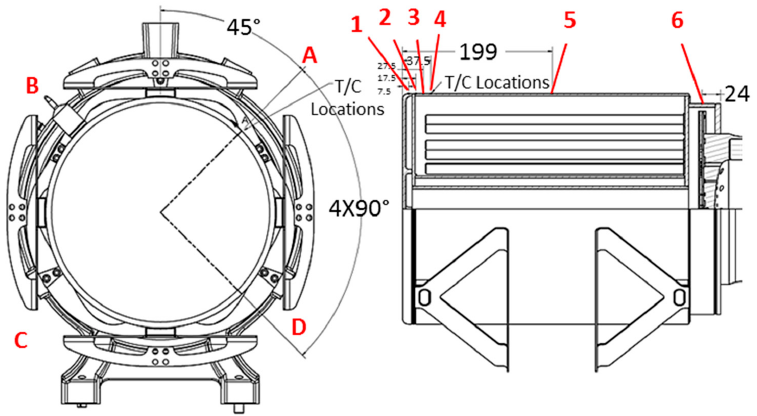
Figure 8. Radial and axial location of thermocouples.